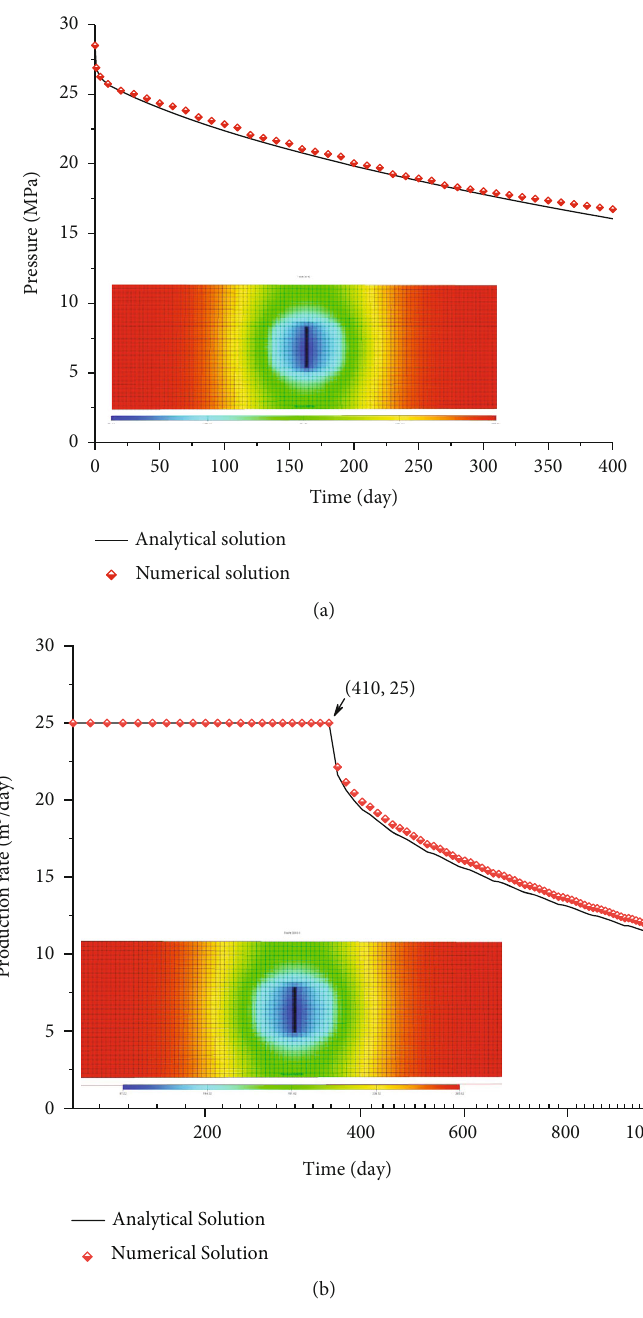
Figure 3: (a) Comparing analytical and numerical solutions in the constant rate system. (b) Comparing analytical and numerical solutions in the compound working